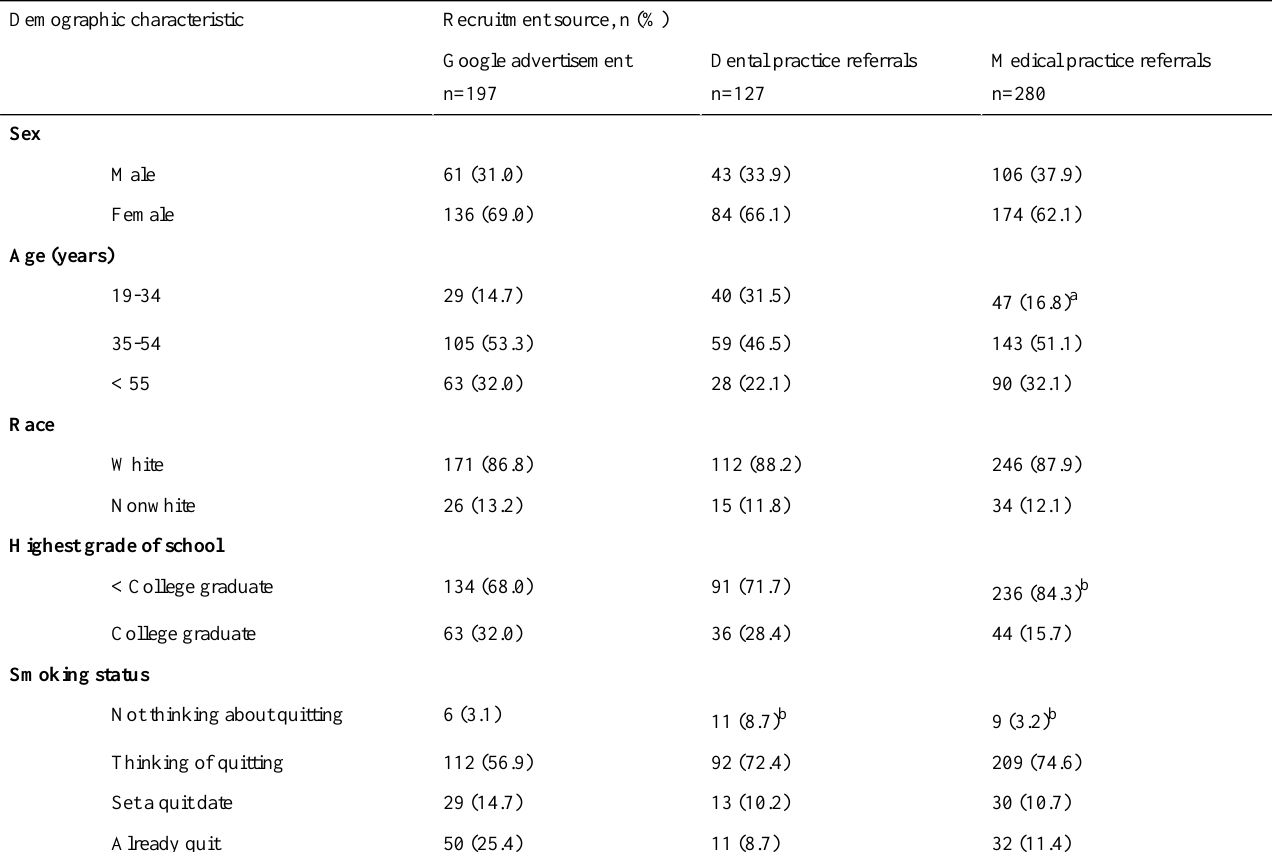
Table 2. Demographic characteristics and readiness to quit of smokers by recruitment source.